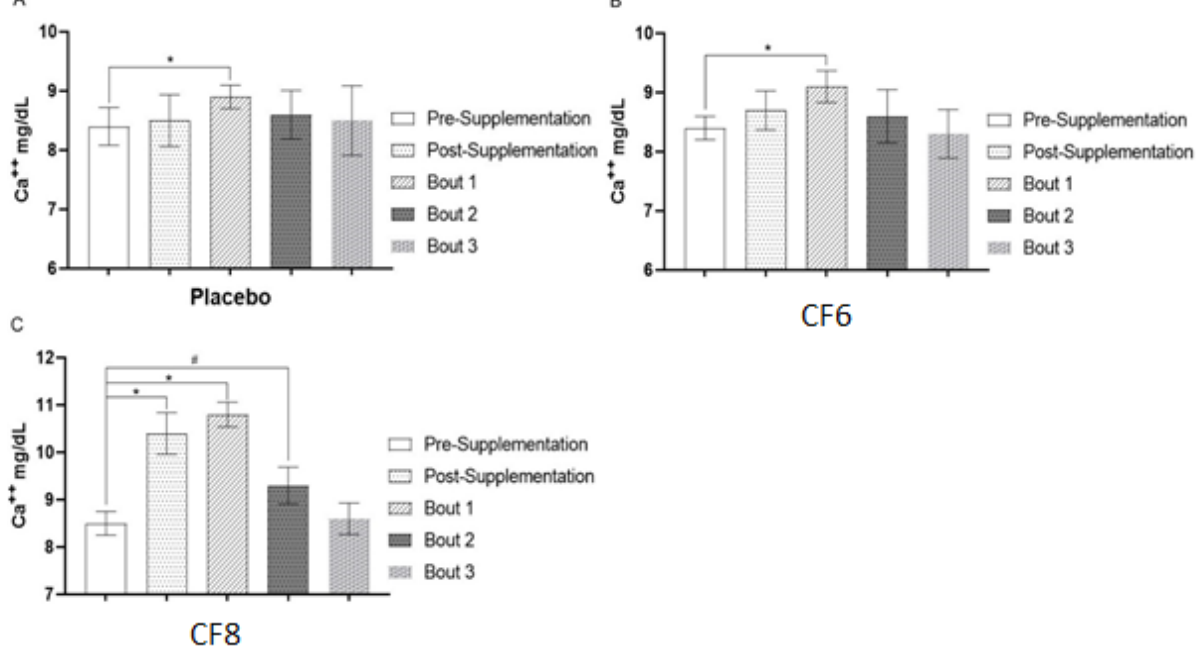
Figure 4. Calcium behavior after supplementation. Figure 2. ( A ) Calcium behavior from pre- supplementation with placebo until the last strength bout analyzed; ( B ) Calcium behavior from pre-supplementation with lower doses of caffeine until the last strength bout analyzed; ( C ) Calcium behavior from pre-supplementation with higher doses of caffeine until the last strength bout analyzed. * = significant differences ( p < 0.05) compared to pre-supplementation; # = significant difference ( p < 0.05) between Bout 2 vs.